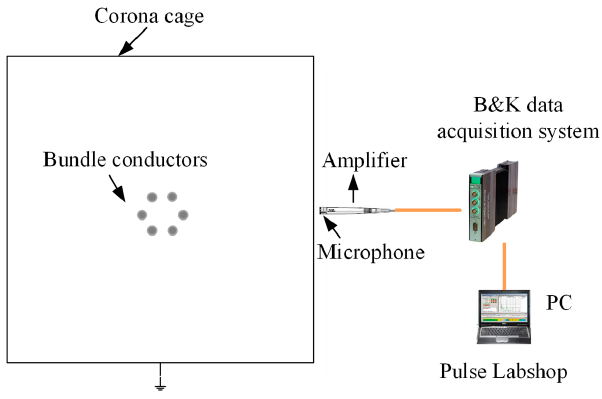
Figure 2. Diagram of AN measurement.